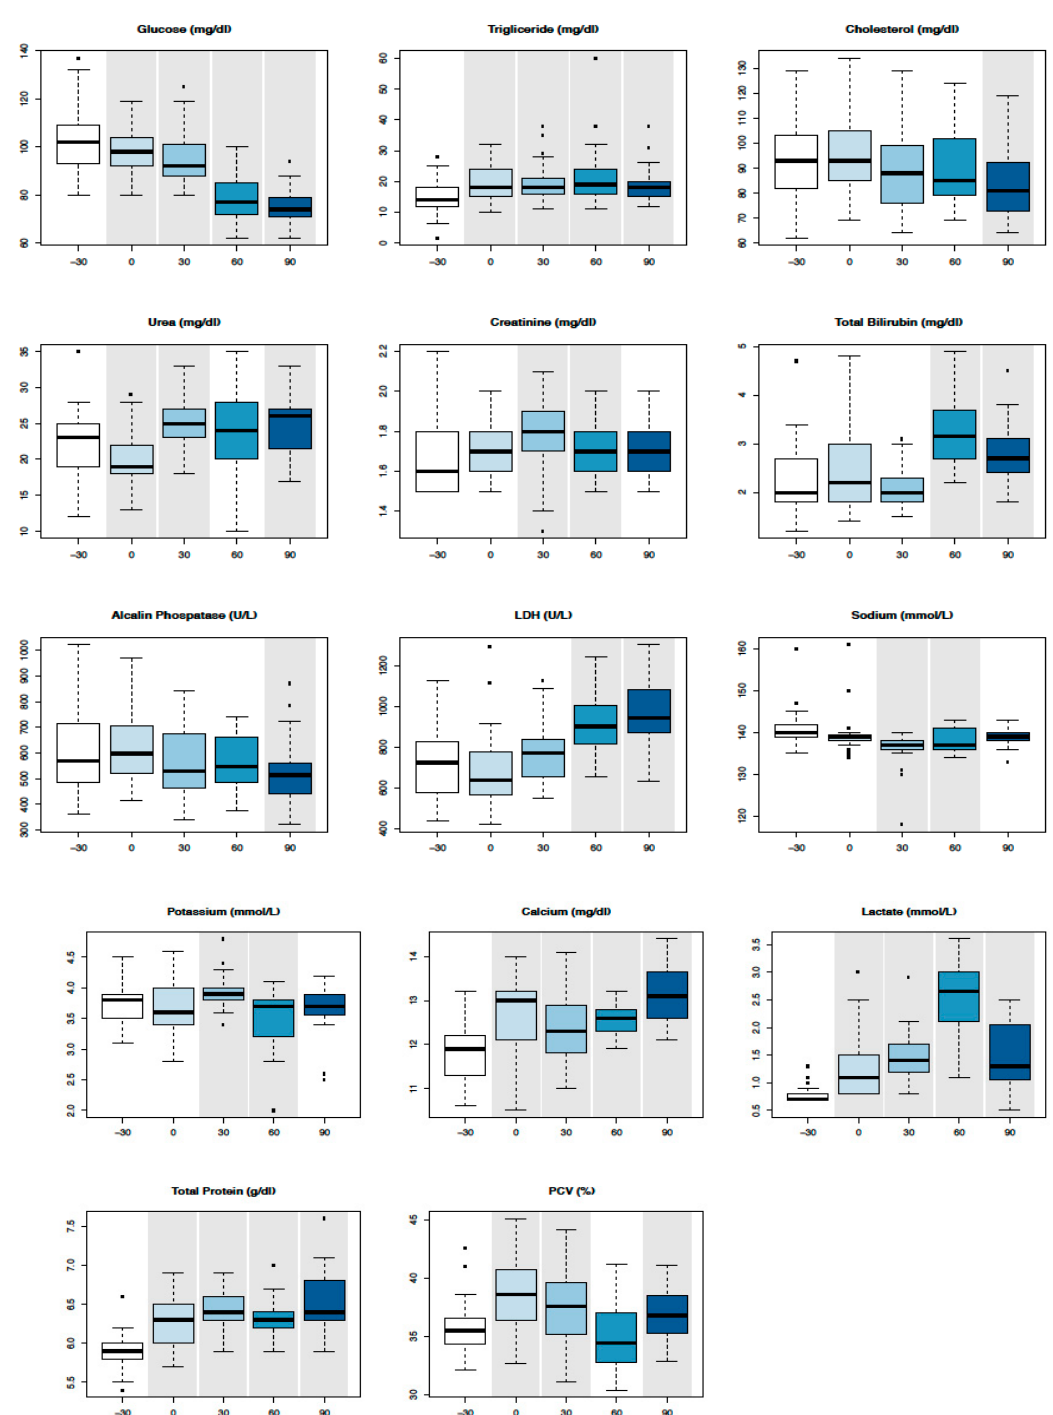
Figure 1. Boxplot with serum biochemical values in the time series. Circles in the plot area represent outliers. Time points that statistically differ from T-30 have a grey background.